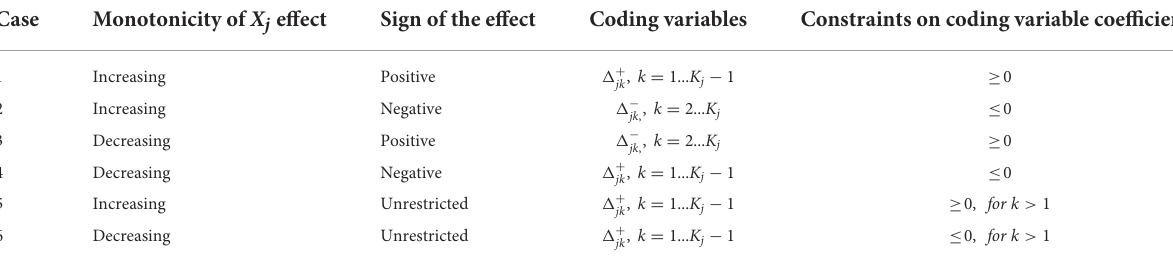
TABLE 1 Coding monotonicity and sign constraints for discretized/ordinal variable X j